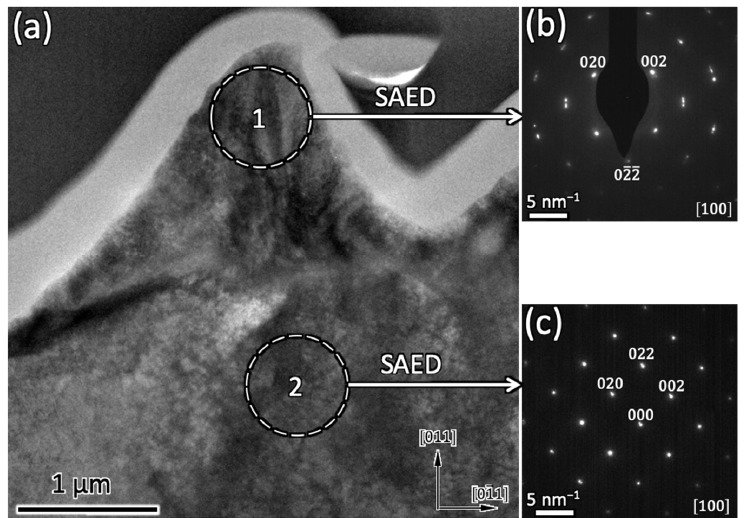
Figure 10. ( a ) Brightfield TEM cross-section of the type A6 microstructures and selected area electron diffraction (SAED) patterns from region 1, in the apex of the protrusion ( b ), and in region 2, just below the protrusion ( c ). The bright layer in ( a ) corresponds to the deposited carbon protection layer for the TEM cross-section specimen preparation.